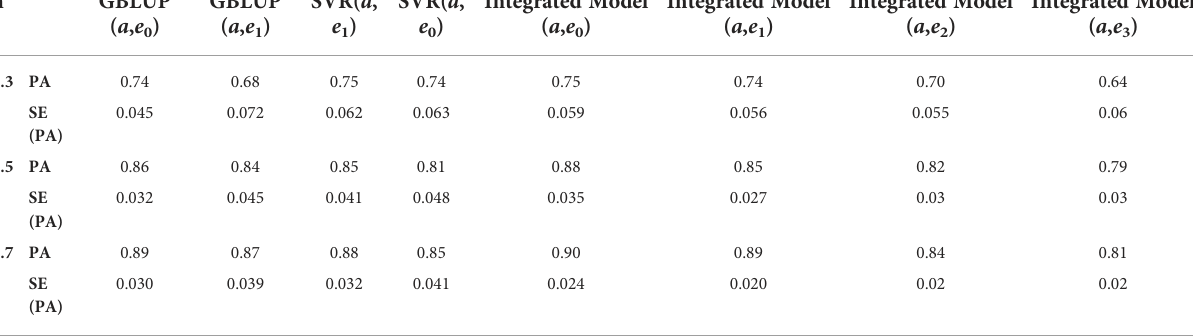
TABLE 5 Predictive ability (PA) with its standard error (SE) for different genomic selection models on mixed architecture (additive and epistatic effects) using RCV variance.